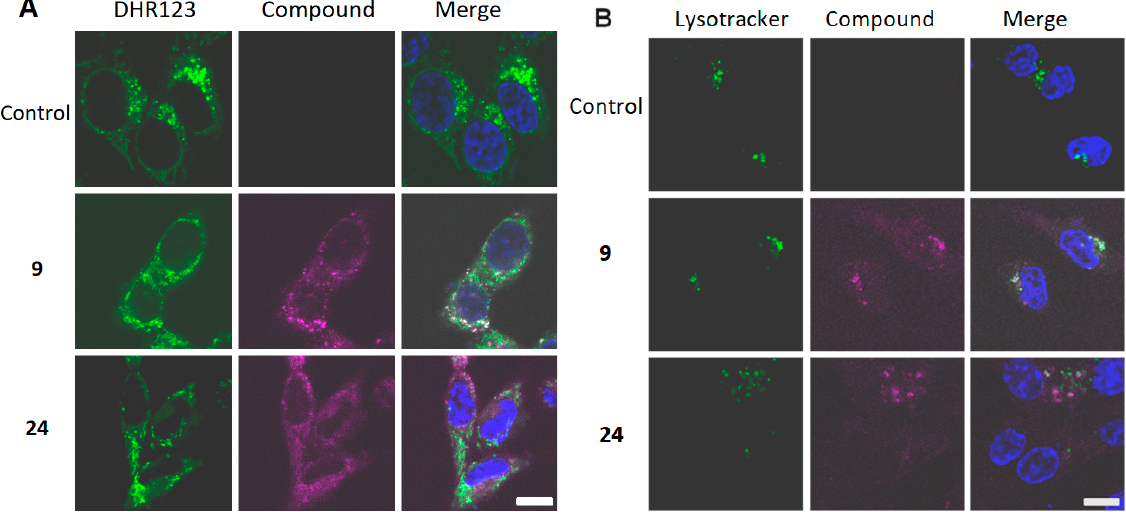
Figure 3. Cytoplasmic distribution of compounds 9 and 24 . The HCT116 cells were loaded with 9 and 24 (10 μ M each) for 24 h at 37 °C, 5%CO 2 in the dark. Colocalization with mitochondria ( A ), lysosomes ( B ). Bar, 15 μ m.